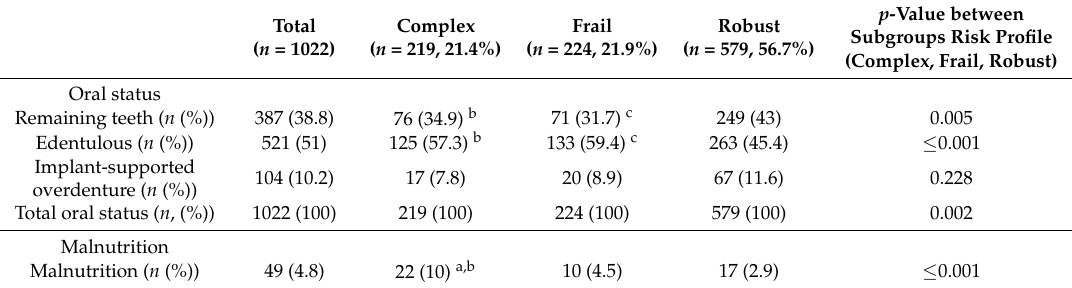
Table 2. Overview of risk profiles and oral status and